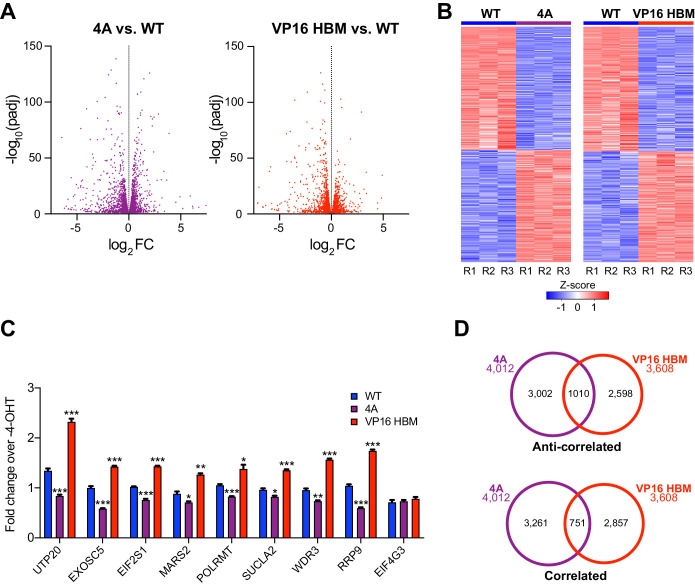
Gene expression changes induced by the 4A and VP16 host cell factor (HCF)–1-binding motif (HBM) mutants.(A) Volcano plots showing the significant (false discovery rate [FDR] < 0.05) gene expression changes for the 4A (left) and VP16 HBM (right) mutants. For clarity, some data points were excluded; these data points are highlighted in Figure 3—source data 1 and 2. (B) Heatmap visualizing consistency among replicates of RNA-Seq for switchable MYC allele cell lines at 24 hr, by z-transformation and ranking by fold-change (FC). Transcripts that were significantly (FDR < 0.05) impacted compared to wild type (WT) are shown. Three biological replicates for each WT, 4A, and VP16 HBM were used to calculate FDR and FCs. (C) Validation of a set of gene expression changes detected in RNA-Seq. Cells were grown with or without 4-OHT for 24 hr, RNA isolated, reverse transcribed, and the indicated transcripts quantified by real-time PCR. Cycle threshold (Ct) values were normalized to those for GAPDH and FCs calculated over −4-OHT samples. Shown are the mean and standard error for three biological replicates. Student’s t-test between WT and mutant cells was used to calculate p-values; *p<0.05, **p<0.01, ***p<0.001. (D) Significant (FDR < 0.05) gene expression changes that are anti-correlative (top) and correlative (bottom) in direction between the 4A and VP16 HBM mutants.